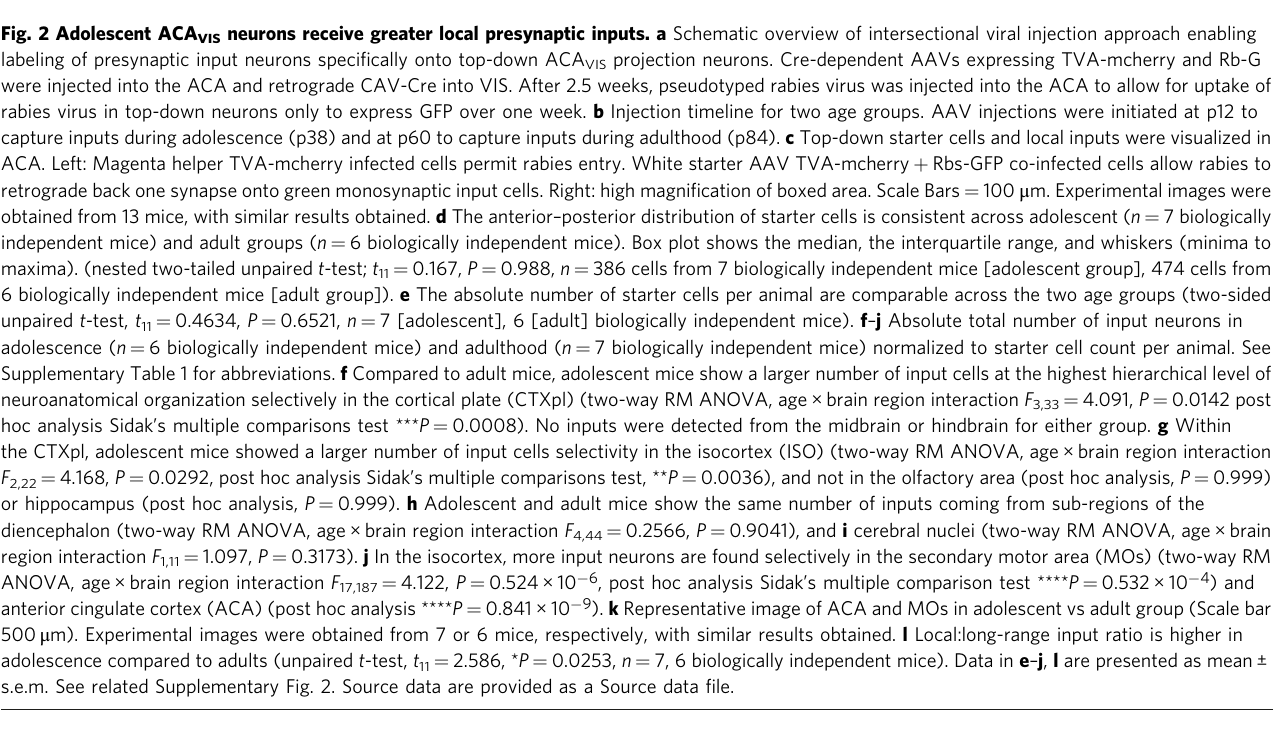
Fig. 2 Adolescent ACA VIS neurons receive greater local presynaptic inputs. a Schematic overview of intersectional viral injection approach enabling labeling of presynaptic input neurons speci fi cally onto top-down ACA VIS projection neurons. Cre-dependent AAVs expressing TVA-mcherry and Rb-G were injected into the ACA and retrograde CAV-Cre into VIS. After 2.5 weeks, pseudotyped rabies virus was injected into the ACA to allow for uptake of rabies virus in top-down neurons only to express GFP over one week. b Injection timeline for two age groups. AAV injections were initiated at p12 to capture inputs during adolescence (p38) and at p60 to capture inputs during adulthood (p84). c Top-down starter cells and local inputs were visualized in ACA. Left: Magenta helper TVA-mcherry infected cells permit rabies entry. White starter AAV TVA-mcherry + Rbs-GFP co-infected cells allow rabies to retrograde back one synapse onto green monosynaptic input cells. Right: high magni fi cation of boxed area. Scale Bars = 100 μ m. Experimental images were obtained from 13 mice, with similar results obtained. d The anterior – posterior distribution of starter cells is consistent across adolescent ( n = 7 biologically independent mice) and adult groups ( n = 6 biologically independent mice). Box plot shows the median, the interquartile range, and whiskers (minima to maxima). (nested two-tailed unpaired t -test; t 11 = 0.167, P = 0.988, n = 386 cells from 7 biologically independent mice [adolescent group], 474 cells from 6 biologically independent mice [adult group]). e The absolute number of starter cells per animal are comparable across the two age groups (two-sided unpaired t -test, t 11 = 0.4634, P = 0.6521, n = 7 [adolescent], 6 [adult] biologically independent mice). f – j Absolute total number of input neurons in adolescence ( n = 6 biologically independent mice) and adulthood ( n = 7 biologically independent mice) normalized to starter cell count per animal. See Supplementary Table 1 for abbreviations. f Compared to adult mice, adolescent mice show a larger number of input cells at the highest hierarchical level of neuroanatomical organization selectively in the cortical plate (CTXpl) (two-way RM ANOVA, age × brain region interaction F 3,33 = 4.091, P = 0.0142 post hoc analysis Sidak ’ s multiple comparisons test *** P = 0.0008). No inputs were detected from the midbrain or hindbrain for either group. g Within the CTXpl, adolescent mice showed a larger number of input cells selectivity in the isocortex (ISO) (two-way RM ANOVA, age × brain region interaction F = 4.168, P = 0.0292, post hoc analysis Sidak ’ s multiple comparisons test, ** P = 0.0036), and not in the olfactory area (post hoc analysis, P = 0.999) 2,22 or hippocampus (post hoc analysis, P = 0.999). h Adolescent and adult mice show the same number of inputs coming from sub-regions of the diencephalon (two-way RM ANOVA, age × brain region interaction F 4,44 = 0.2566, P = 0.9041), and i cerebral nuclei (two-way RM ANOVA, age × brain region interaction F 1,11 = 1.097, P = 0.3173). j In the isocortex, more input neurons are found selectively in the secondary motor area (MOs) (two-way RM ANOVA, age × brain region interaction F 17,187 = 4.122, P = 0.524 × 10 − 6 , post hoc analysis Sidak ’ s multiple comparison test **** P = 0.532 × 10 − 4 ) and anterior cingulate cortex (ACA) (post hoc analysis **** P = 0.841 × 10 − 9 ). k Representative image of ACA and MOs in adolescent vs adult group (Scale bar 500 μ m). Experimental images were obtained from 7 or 6 mice, respectively, with similar results obtained. l Local:long-range input ratio is higher in adolescence compared to adults (unpaired t -test, t 11 = 2.586, * P = 0.0253, n = 7, 6 biologically independent mice). Data in e – j , l are presented as mean ± s.e.m. See related Supplementary Fig. 2. Source data are provided as a Source data fi